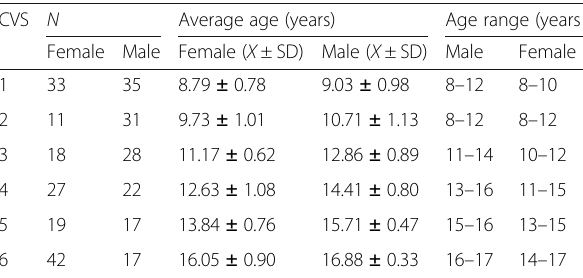
Table 5 The descriptive statistics of the males ’ and females ’ age by